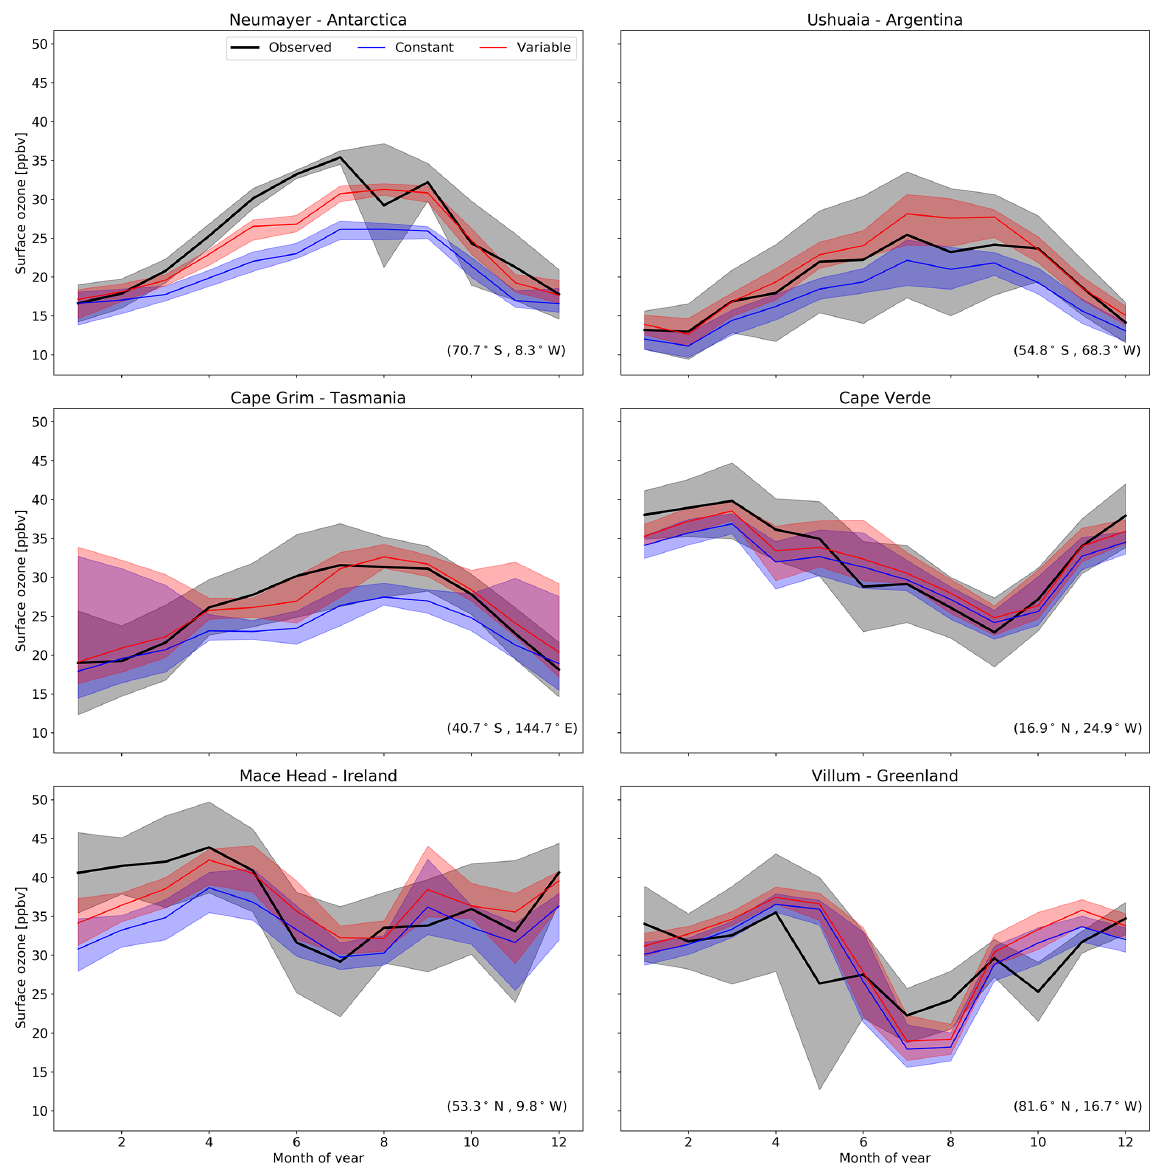
Figure 9. Predictions and observations of monthly average surface ozone mixing ratio for 2014 from the model using the default (constant) and new (variable) parameterization for r c for six GAW stations (with the latitude and longitude for each station at the bottom right), with the shaded region representing the 25th to 75th